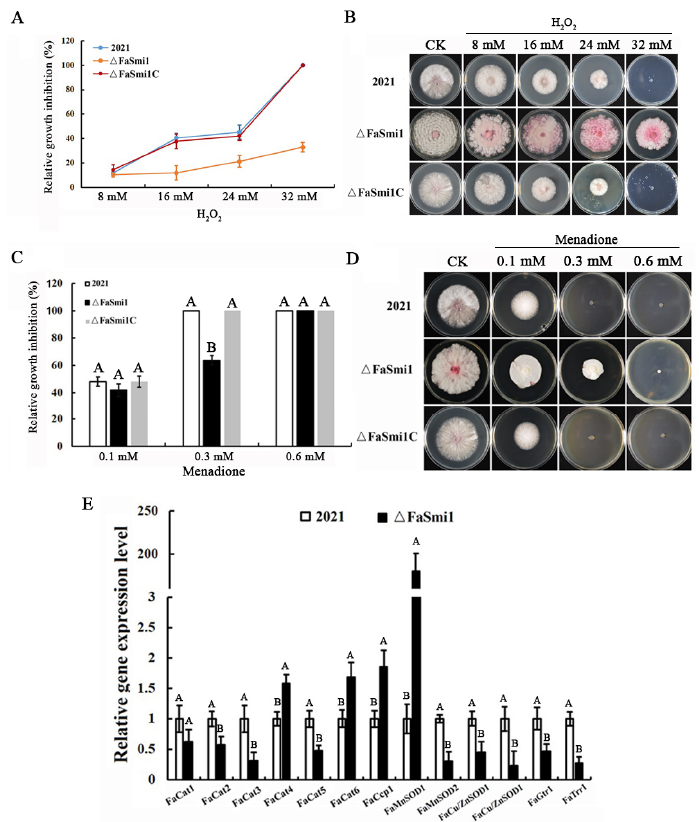
Figure 4. Sensitivity of 2021, ∆ FaSmi1 and ∆ FaSmi1C to oxidation stress. ( A ) Each strain was incubated on PDA supplement with different concentration H 2 O 2 . When the colony diameter of the control treatment was greater than 6 cm, mycelial growth inhibition rate of each strain was analyzed. Bars denote standard deviation from three experiments. Values on the bars followed by the same letter are not significantly different at p = 0.05. ( B ) Colony morphology of each stain grown on PDA medium modified with different concentration H 2 O 2 . ( C ) Each strain was incubated on PDA supplement with different concentrations of menadione. When the colony diameter of the control treatment was greater than 6 cm, mycelial growth inhibition rates of each strain were analyzed. Bars denote standard deviation from three experiments. Values on the bars followed by the same letter are not significantly different at p = 0.05. ( D ) Colony morphology of each strain grown on PDA medium modified with different concentration menadione. ( E ) Relative expression levels of antioxidant system-related genes in 2021 and ∆ FaSmi1 . Line bars in each column denote standard errors of three repeated experiments. Values on the bars followed by the same letter are not significantly different at p =